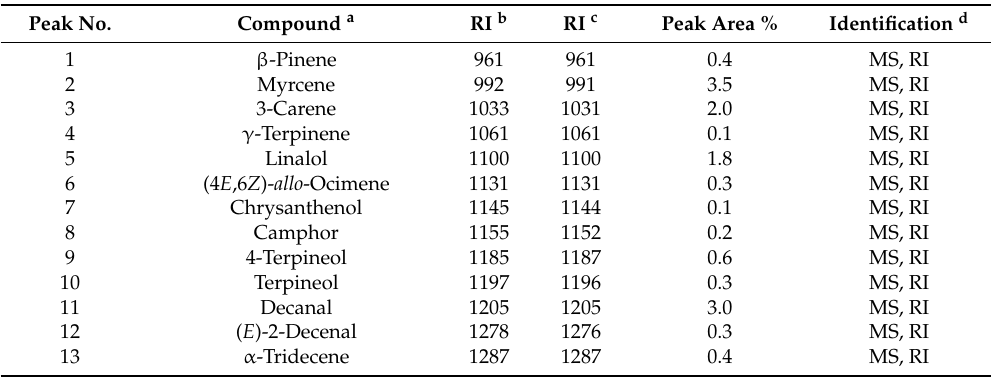
Table 1. Chemical composition of Geophila repens essential oil